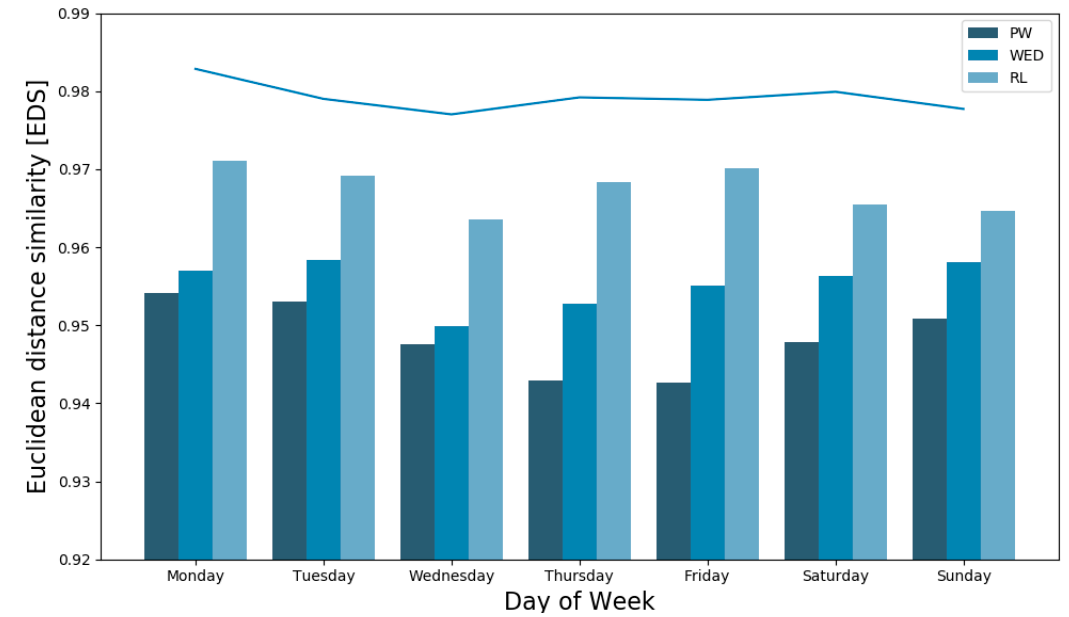
Figure 10. Similar day selection performance of the models in March and April 2018.